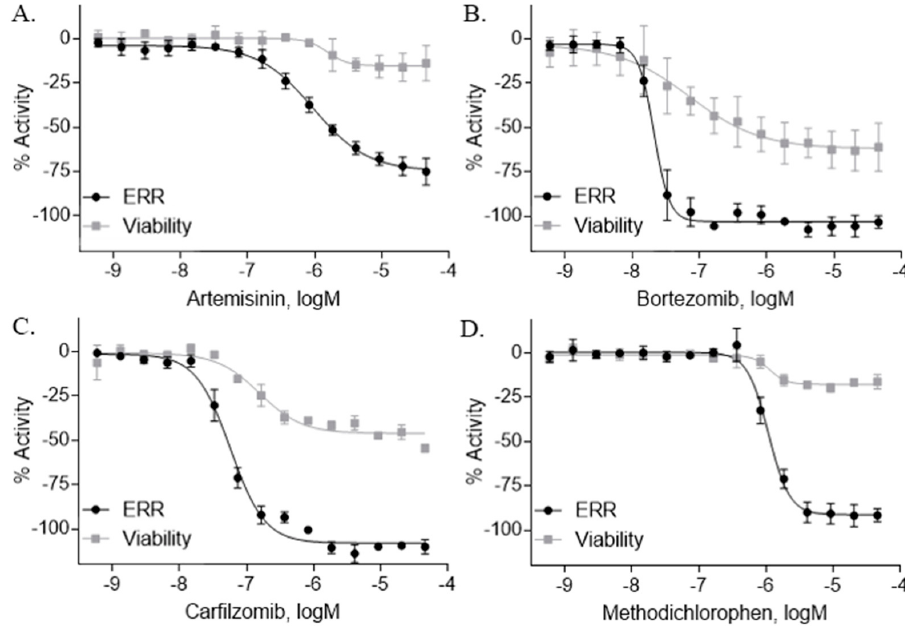
Figure 1. Concentration response curves of novel ERR α anticancer antagonists. Fifteen point dilutions, from the 10K ERR α antagonist and viability screen, of artemisinin ( A ), bortezomib ( B ), carfilzomib ( C ), and methodichlorophen ( D ) were completed. The ERR reporter cell line was treated with each compound for 18 h. The luminescence intensity was calculated after the addition of ONE-Glo to each well. The efficacy of each compound was then compared to the positive control, XCT790. Data are expressed as mean ± SD from triplicate experiments for each assay.